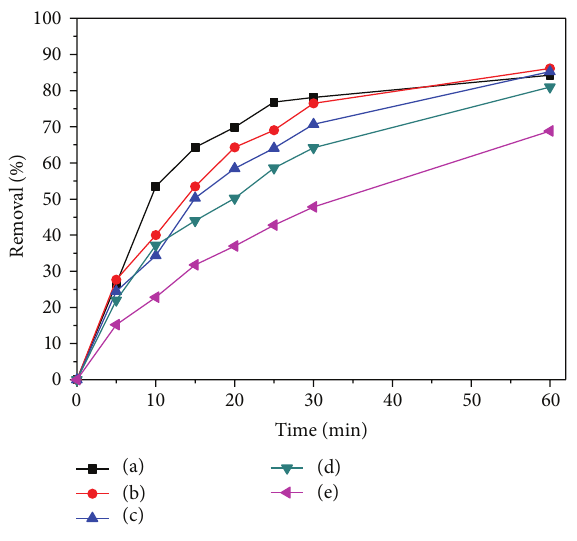
Figure 5: Effect amount of NBH. (a) 0.5 g, (b) 0.2 g, (c) 0.1 g, (d) 0.05 g, and (e) 0.025 g.